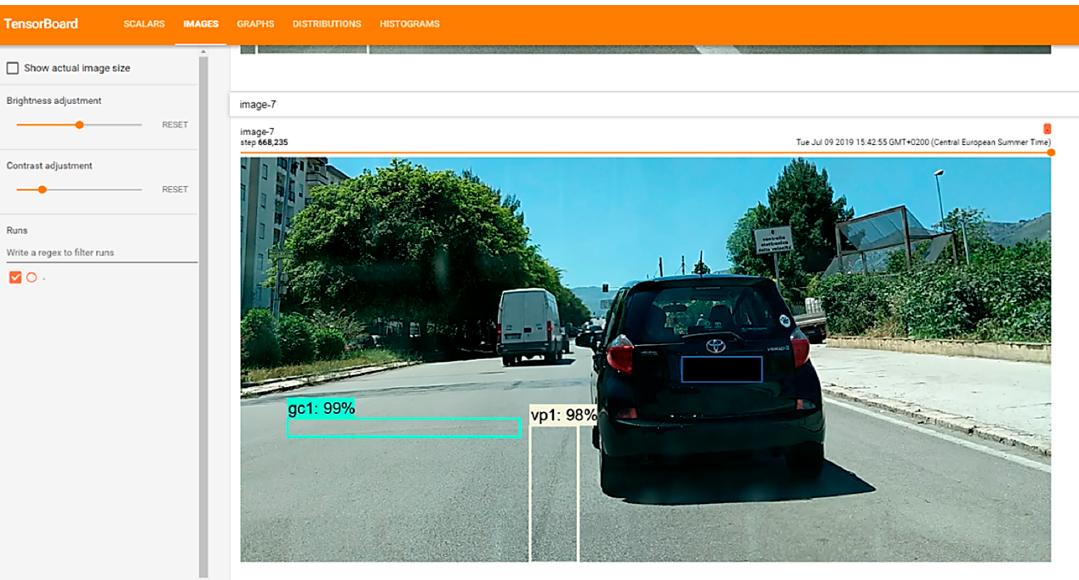
Figure 11. TensorBoard environment utilized during the training of the network.